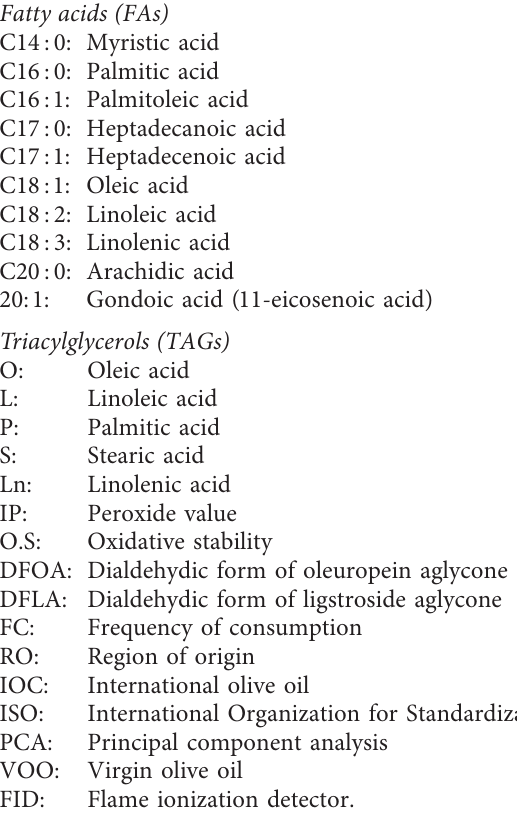
Figure 4: Pairwise comparison between the